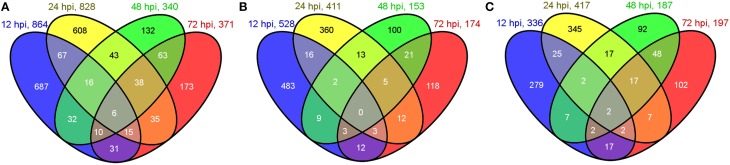
Venn diagram of DEGs at 12, 24, 48, and 72 hpi. (A) Numbers of total DEGs. (B) Numbers of upregulated DEGs. (C) Numbers of downregulated DEGs. Numbers in overlapping areas shows the shared DEGs at different time points.